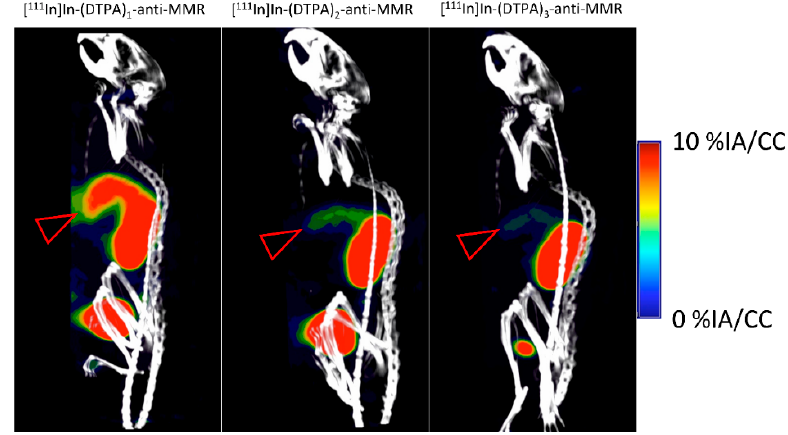
Figure 7. Ex vivo biodistribution analysis of [ 111 In]In-(DTPA) n -anti-MMR fractions in C57Bl/6 mice ( n = 6 per group), with a resistant LLC tumor variant. (* p < 0.05, ** p < 0.01, **** p < 0.001).